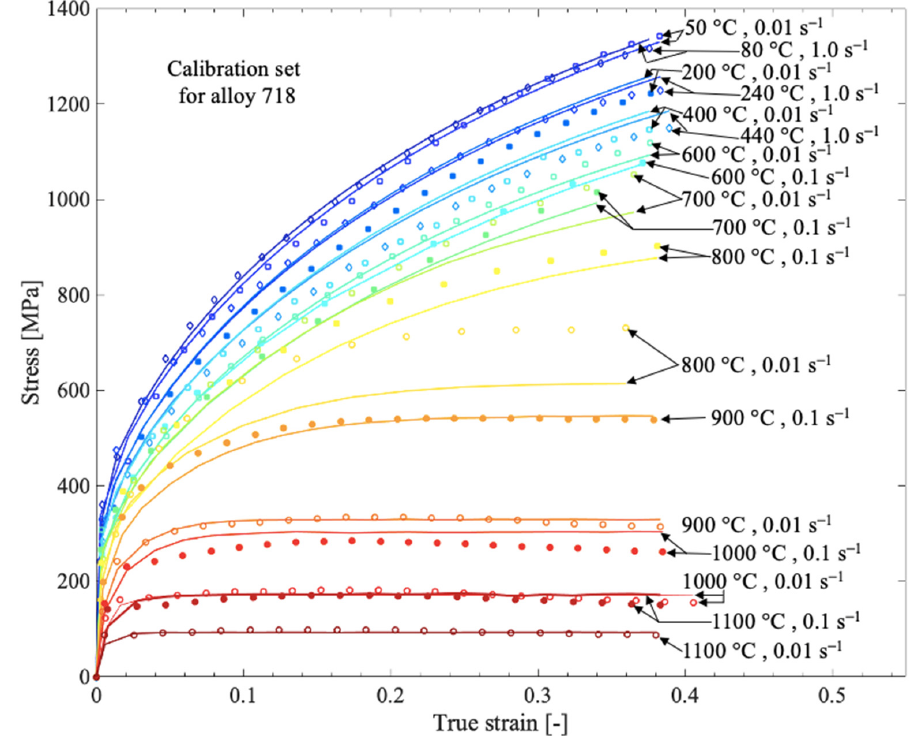
Figure 3. Measured flow stress curves (discrete points) for alloy 718 and corresponding computed result (solid lines) from the material model after